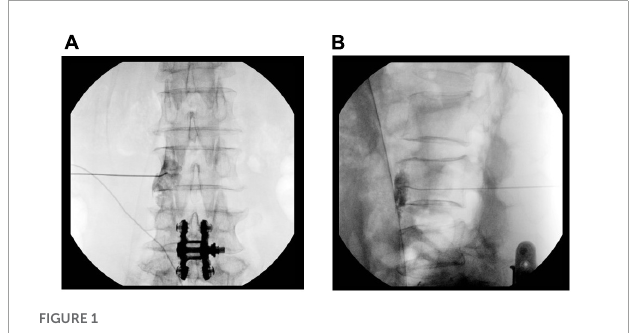
FIGURE1 Fluoroscopic image of the lumbar sympathetic ganglion block. (A) Anteroposterior view of contrast media spread. (B) Lateral view of contrast media spread.